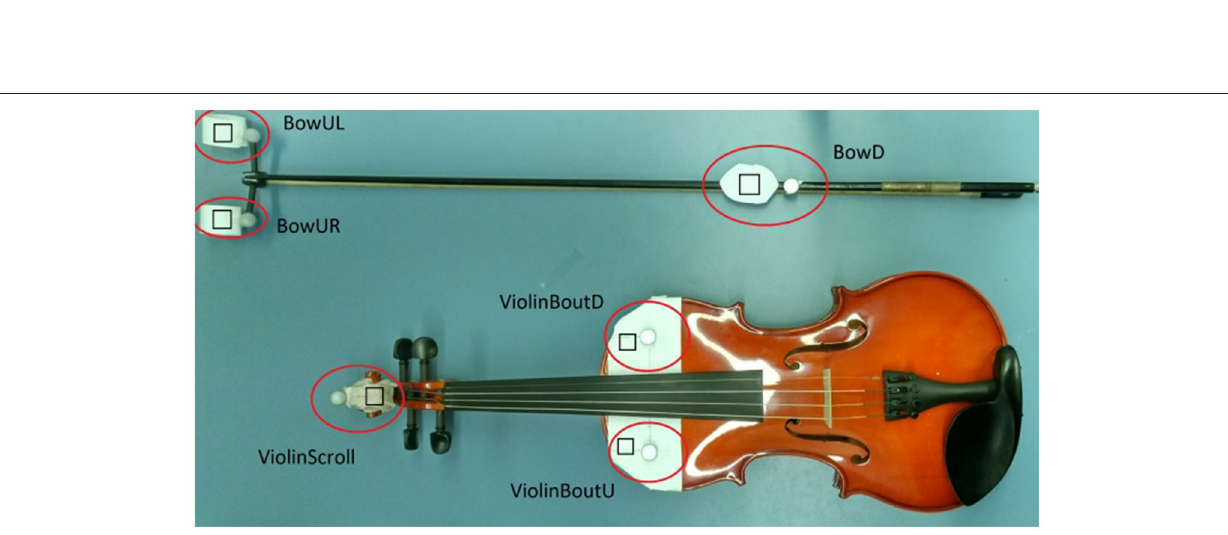
Frontiers in Psychology |